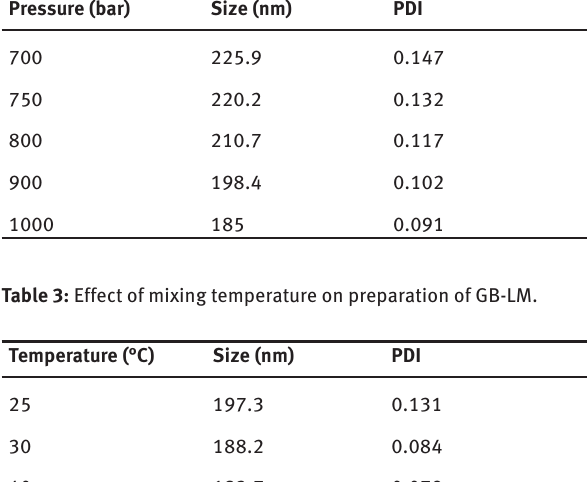
Table 5: The results of orthogonal experimental design for GB-LM. Level